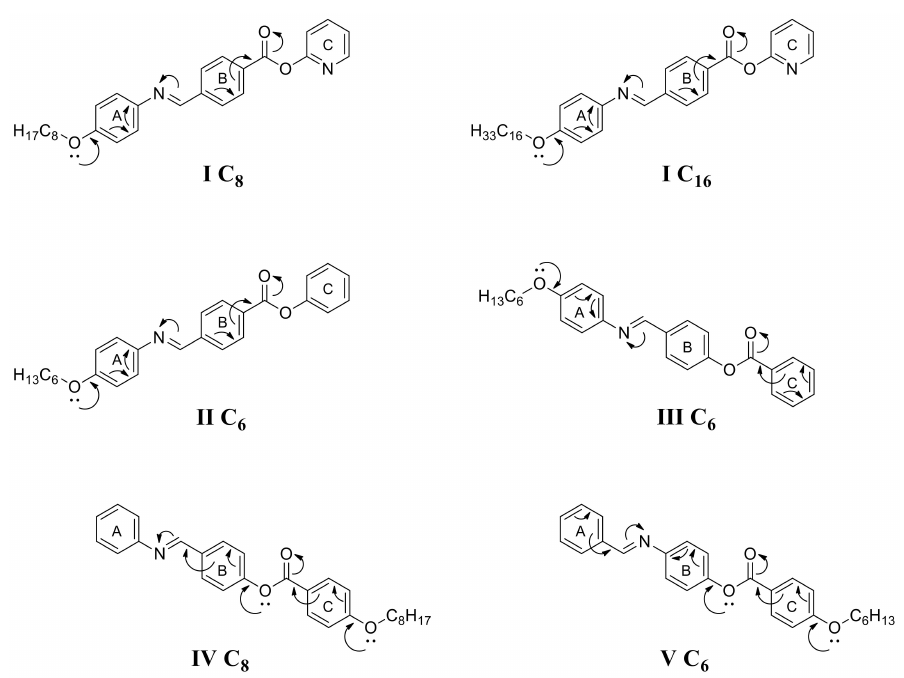
Figure 9. The estimated frontier molecular orbitals of compounds I C 8 , I C 16 , II C 6 , III C 6 , IV C 8 , and V C 6 .